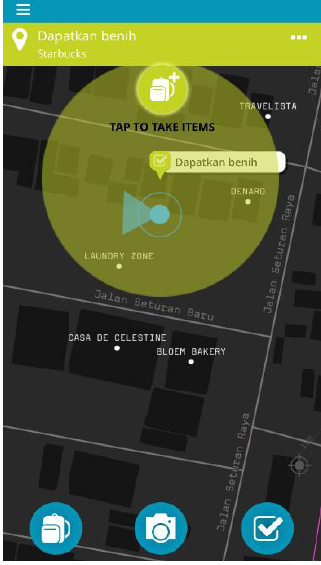
Figure 6. Basic user interfaces of The Game of Peat In order to activate the AR Camera, or to put items in a designated location, the player should be situated nearby the location. A hint is displayed at the top of the screen when the player walks nearby an item or location for placing seeds. The inventory screen shows each item collected and their numbers, while the task screen shows every task that the user needs to complete before the time runs out.